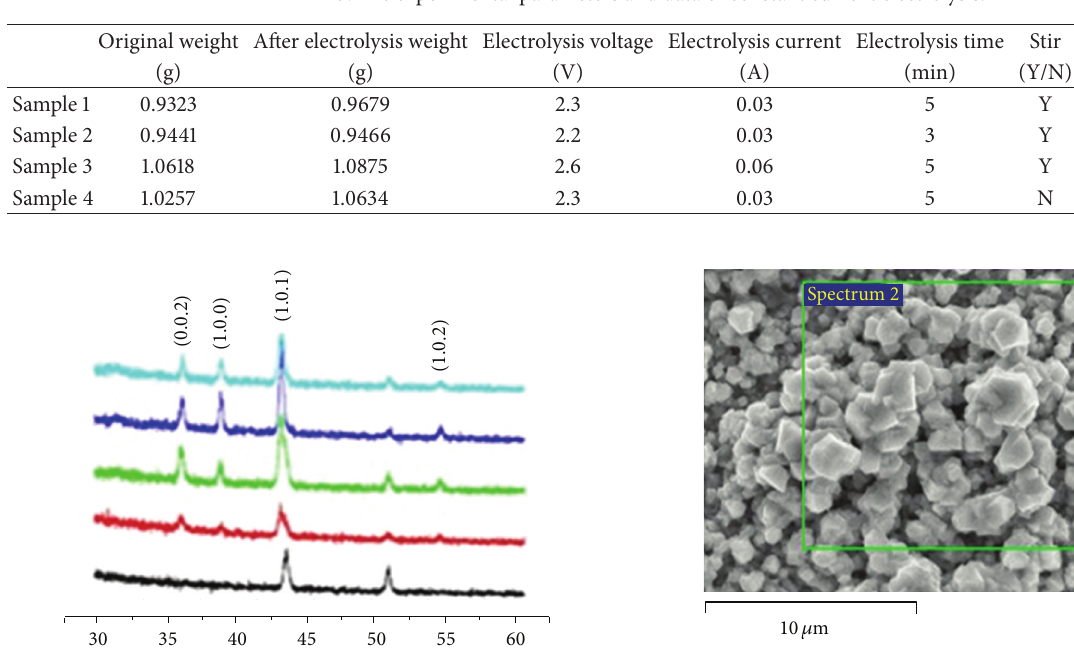
Figure 8: Scanning electron microscopy image of sample 1 plated layer.